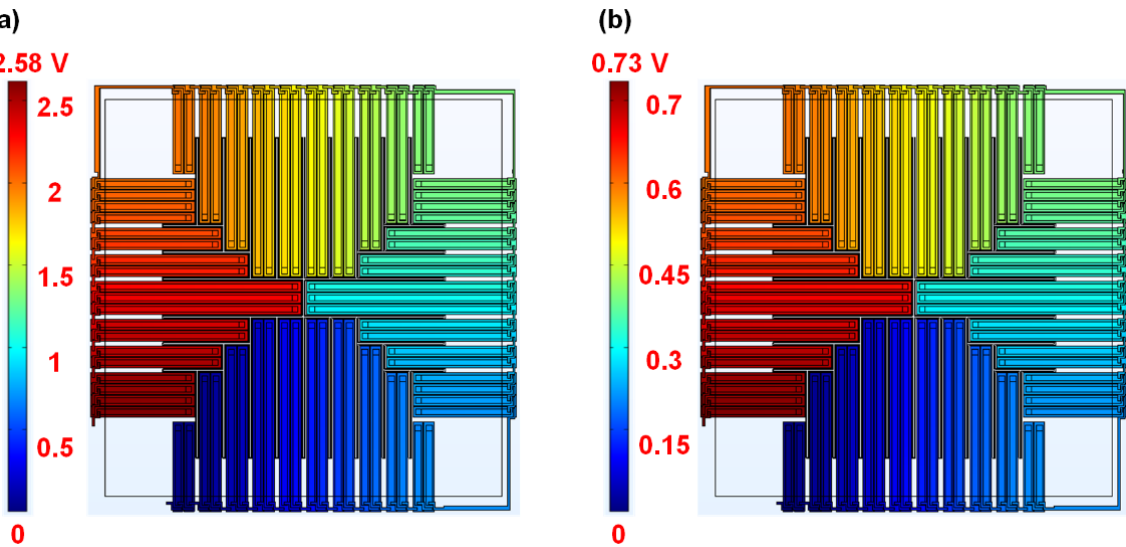
Figure 4. Voltage distribution of thermopile devices embedded with different microheaters: ( a ) Al — based; ( b ) Pt — based.